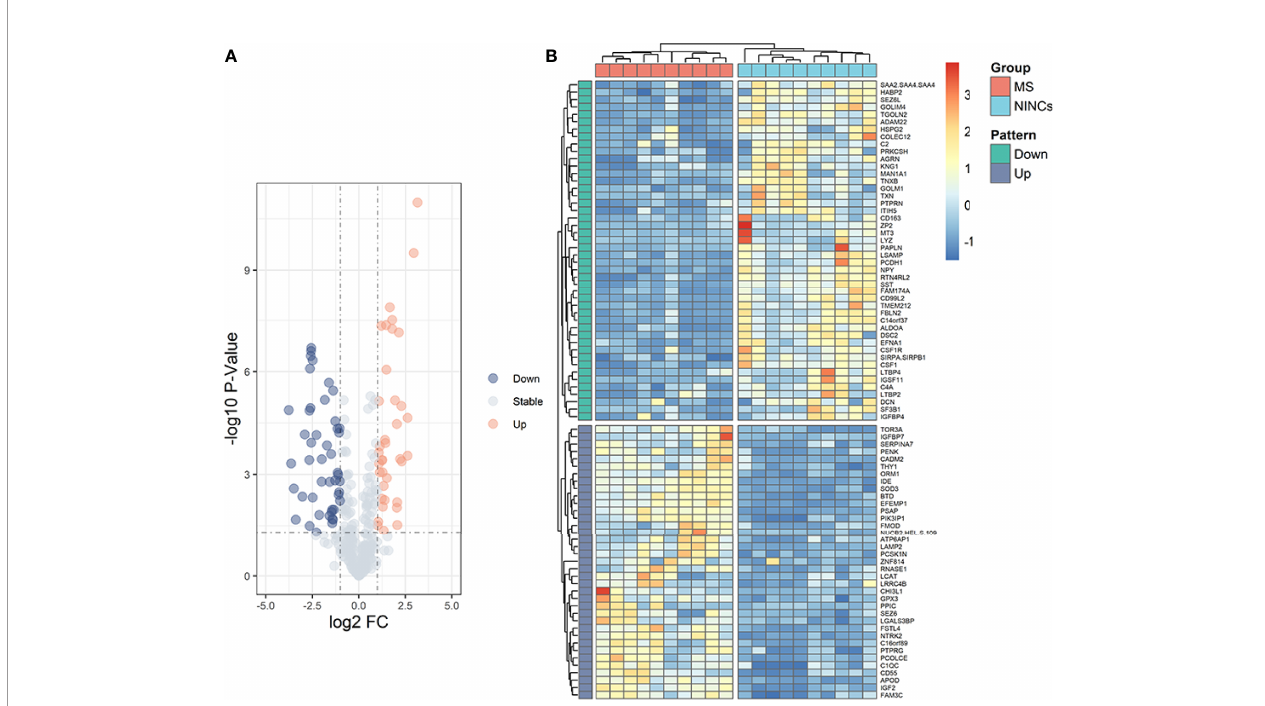
FIGURE 1 | Volcano plot (A) and heatmap (B) of patients with MS vs NINCs. (A) The volcano plot was drawn using two factors, the fold change (Log2) between the two groups of samples and the p-value ( − Log10) obtained from the t-test, to show the signi fi cance of differences in the data between the two groups of samples. The orange dots and blue dots in the fi gure are proteins that were signi fi cantly upregulated and downregulated, respectively; the gray dots are proteins with no signi fi cant difference. (B) Hierarchical clustering analysis of DEPs in CSF between patients with MS (orange) and NINCs (blue). Each row in the fi gure represents a protein, and each column represents a sample. Red, high expression; dark blue, low expression. Two main clusters of proteins were observed, one of which was downregulated and one of which upregulated in patients with